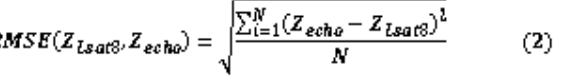
Figure 3. Two different maps (the difference of predicted depth from known depth) by bands 1, 3 and 4 without logarithmic transformation (A); with logarithmic transformation